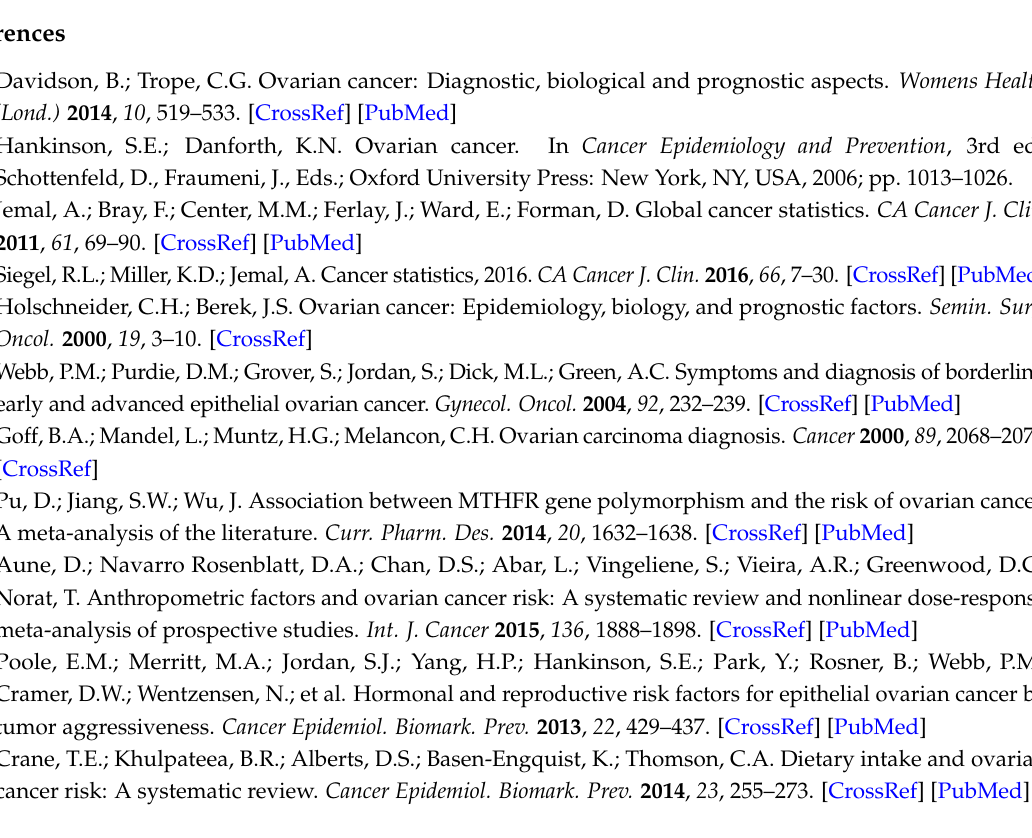
Table S1: Quality assessment of studies included in the meta-analysis, Figure S1: Meta-analysis of the association between dietary plus supplemental calcium intake and ovarian cancer risk, Figure S2: Meta-analysis of the association between dairy calcium intake and ovarian cancer risk. Figure S3: Influence analysis of an individual study on the pooled estimate for studies on the association between dietary calcium intake and ovarian cancer risk, Figure S4: Influence analysis of an individual study on the pooled estimate for studies on the association between dietary plus supplemental calcium intake and ovarian cancer